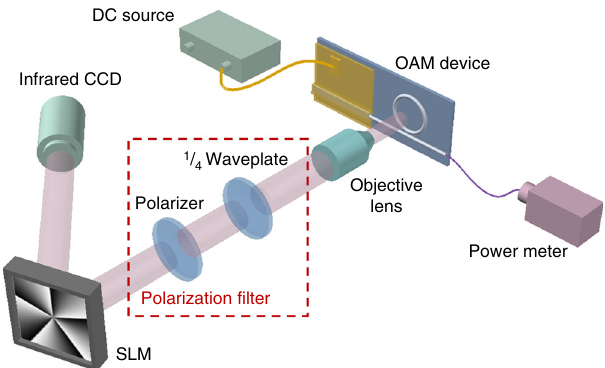
Fig. 3 Experimental setup for OAM beam characterization. The topological charge and mode purity of the OAM beam is measured with an SLM in combination with a polarization fi that the two-lobed pattern is parallel to the polarizer axis, con fi rming radial polarization of the radiated beam.